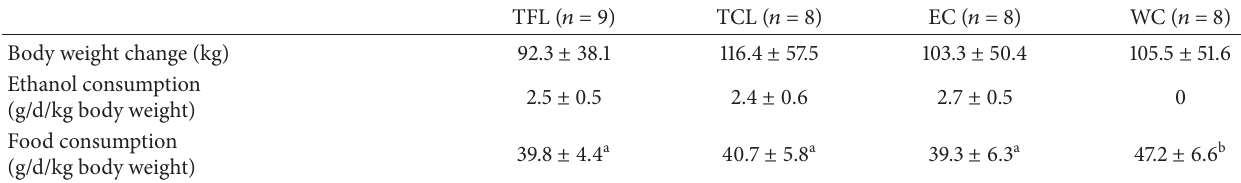
Table 2: Body weight change and ethanol and food intake of SD rats.